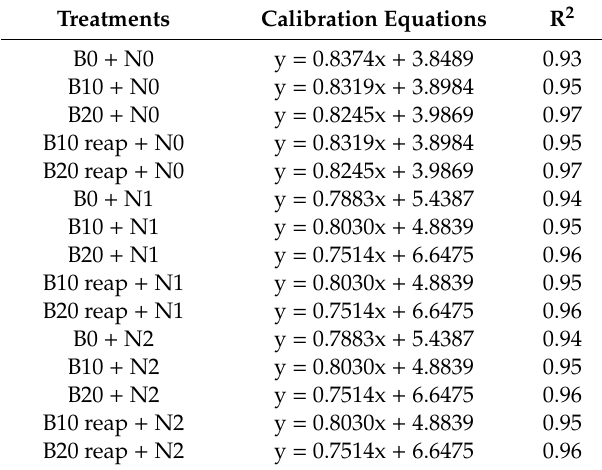
Table 4. Equations used to calibrate the measured values of soil water content.